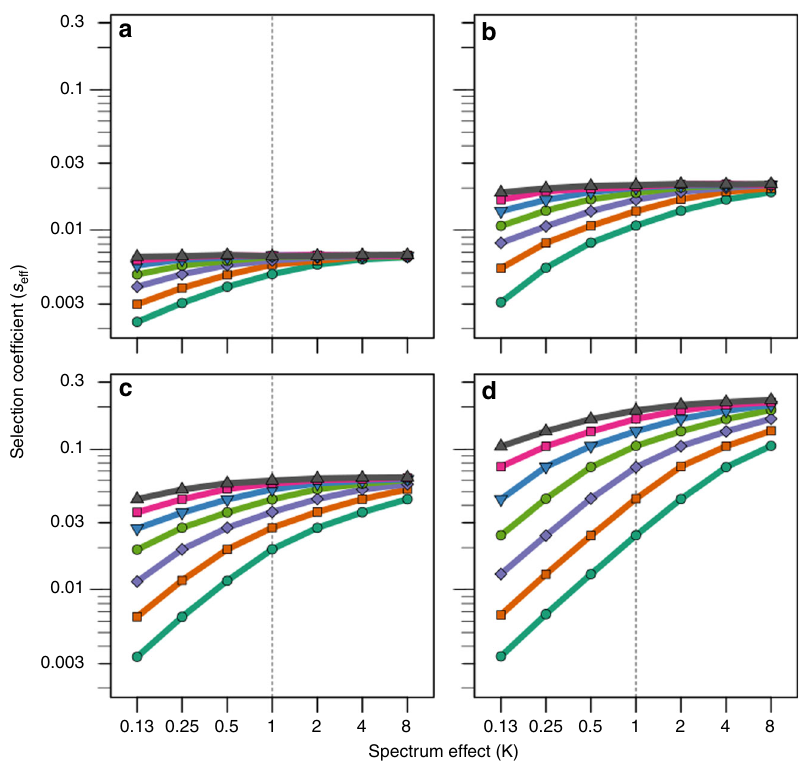
Fig. 2 Mutational spectrum effects on the invasion speed of antimutator alleles. Points represent the effective selection coef fi cient ( s eff ) of the invading antimutator alleles, averaged from 200 independent simulations. Panels correspond to different values of the mutation rate of the resident mutator ( a , m = 30; b , m = 100; c , m = 300; d , m = 1000). Within each panel, lines depict different values for the fi tness cost of deleterious mutations (from top to bottom, s d equals: 0.064, 0.032, 0.016, 0.008, 0.004, 0.002, 0.001). Mutational spectrum effects refers to the differential propensity of mutators to produce deleterious mutations with different fi tness cost. We modelled this effect as a multiplicative factor ( κ ) that modi fi es s d in the mutator background, such that when κ < 1 mutators produce milder deleterious mutations than antimutators, when κ = 1 there is no difference between backgrounds, and when κ > 1 mutations are more harmful in mutators. The basal deleterious mutation rate ( u d ) is set to 2 × 10 − 4 (other parameters as described in